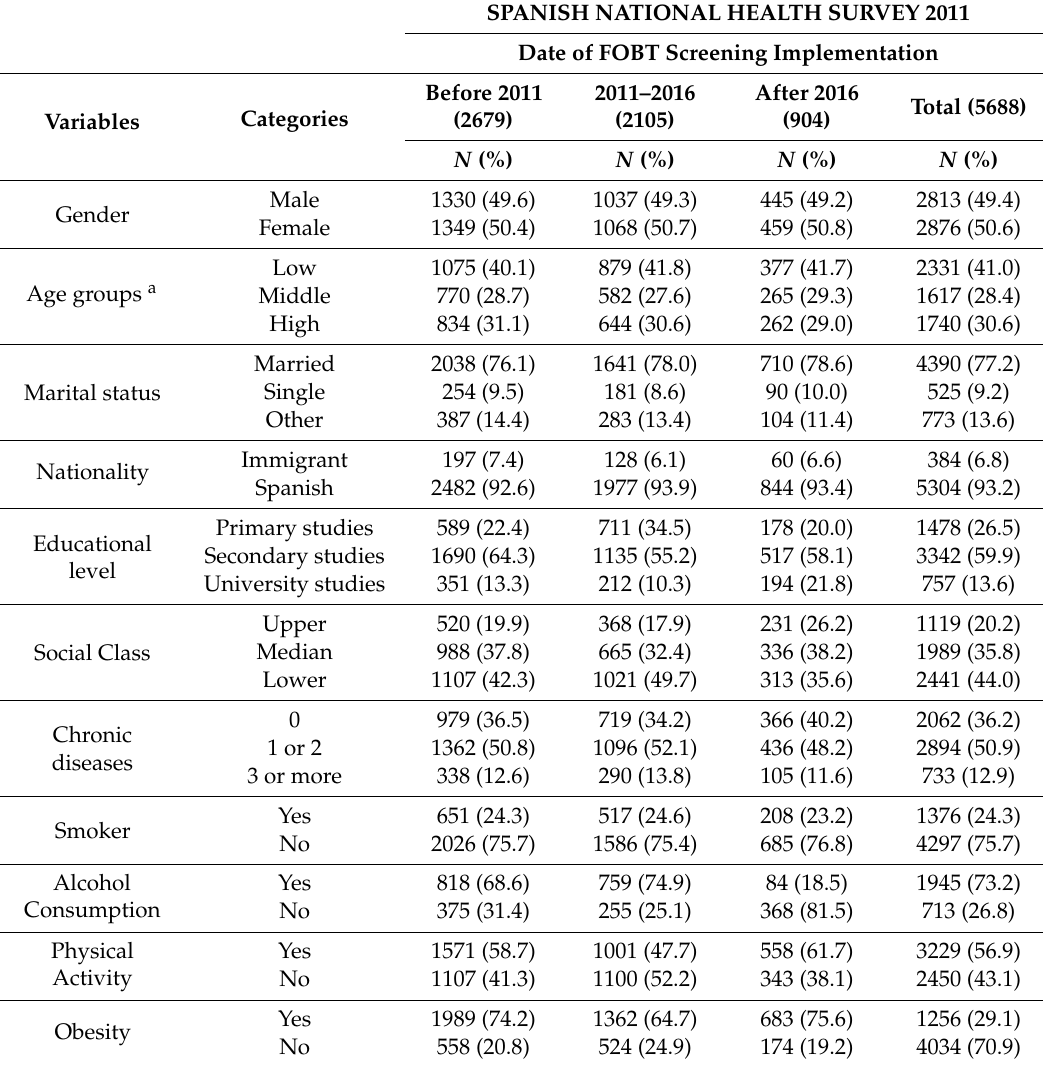
Table 1. Distribution of study populations for the fecal occult blood test (FOBT) screening by study variables according to the date colorectal cancer (CRC) programs were implemented. Results from the Spanish National Health Survey